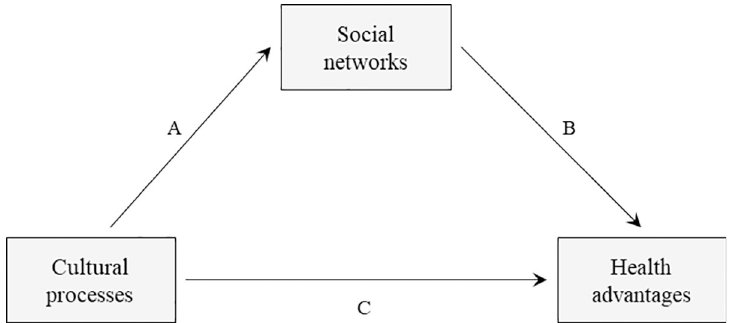
Fig 1. The sociocultural health resilience model. This adapted figure from Ruiz and colleagues [1] illustrates how social networks (family, community) mediate the association between Latinxs’ cultural processes and health